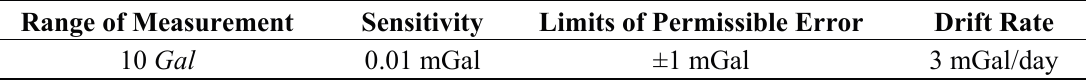
Table 7. The main parameters of Chekan-AM marine gravimeter.